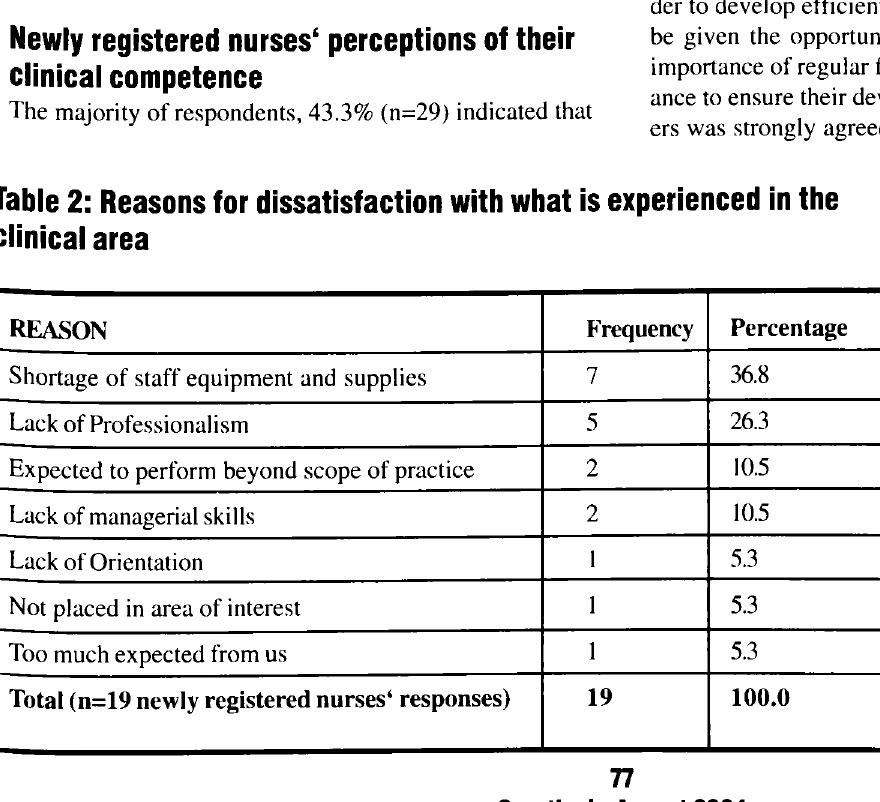
Table 2: Reasons for dissatisfaction with what is experienced in the clinical